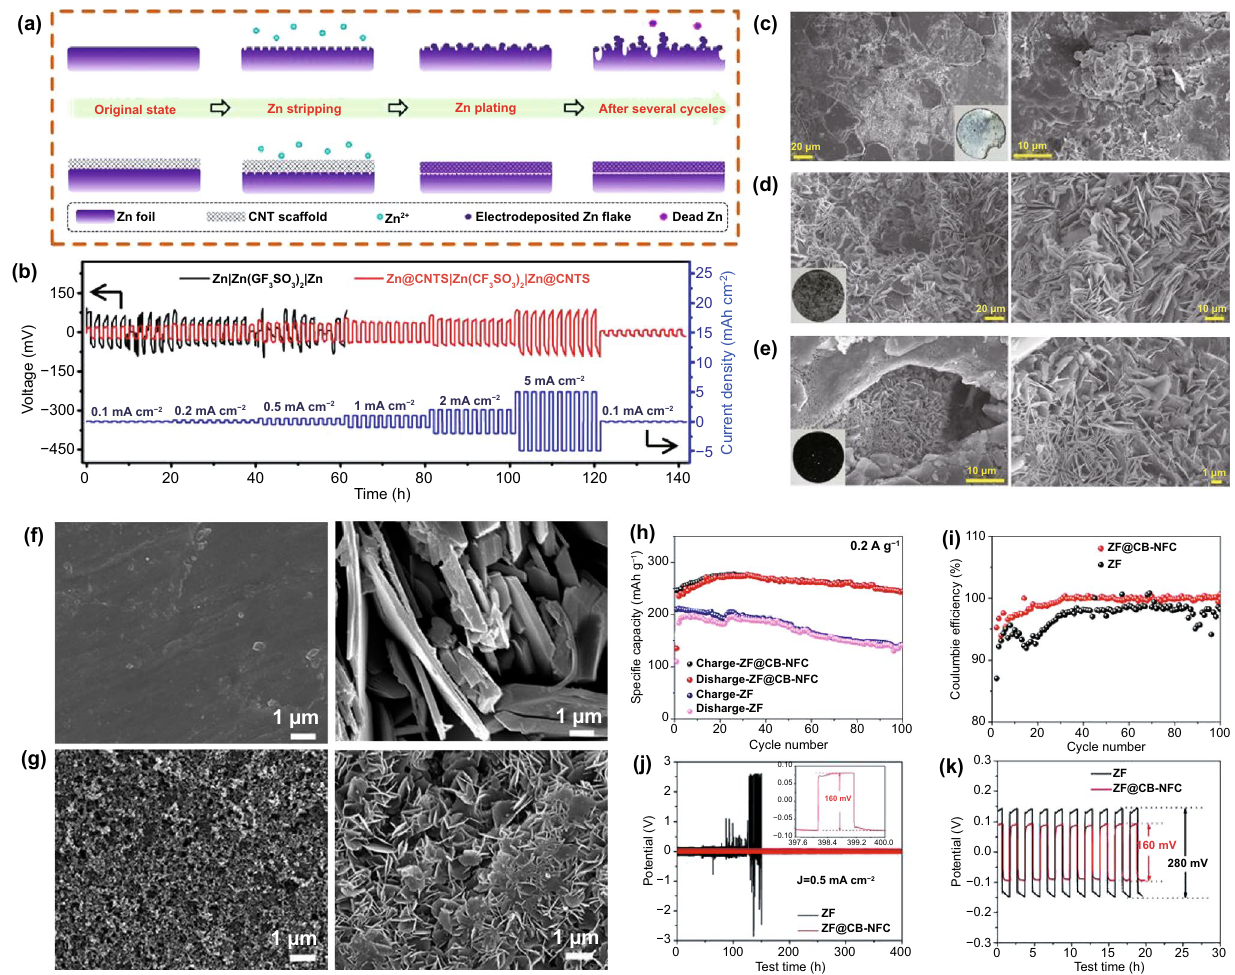
Fig. 5 a Schematics of the stripping/plating behaviors of bare ZF anodes and CNT scaffold-stabilized Zn anodes. b Rate performance at various current densities of 0.1–5 mA cm −2 for 1 h. c SEM image of Zn electrodes in Zn||Zn symmetrical cells. d SEM image of Zn electrodes in Zn@ CNTs symmetrical cells. e SEM image of CNT scaffolds in Zn@CNTs symmetrical cells (after cycling tests). Copyright 2019 Elsevier [91]. f SEM images of a ZF anode and g SEM images of a ZF@CB-NFC anode. h Cycling performances at 0.2 A g −1 . i Coulombic efficiencies as a function of the cycle number. j Zn symmetrical cells with ZF and ZF@CB-NFC electrodes: galvanostatic charge/discharge (GCD) curves of 200 cycles at 0.5 mA cm −2 . k Zn symmetrical cells with ZF and ZF@CB-NFC electrodes: voltage profiles of the 1st–10th cycles at 0.5 mA cm −2